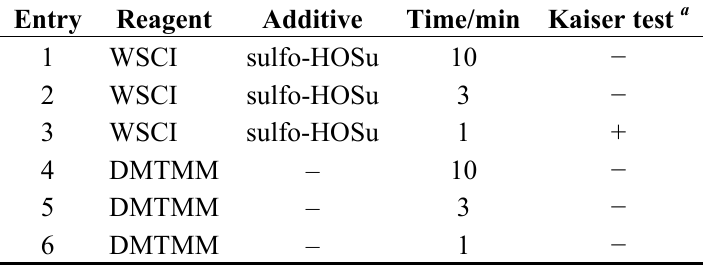
Table 1. Study of MW assisted solid-phase coupling reaction in water [24]. Reactions were carried out between Boc-Phe-OH nanoparticles and H-Gly-Rink amide-PEG grafted resin. Entry Reagent Additive Time/min Kaiser test a 1 WSCI sulfo-HOSu 10 − 2 WSCI sulfo-HOSu 3 − 3 WSCI sulfo-HOSu 1 + 4 DMTMM – 10 − 5 DMTMM – 3 − 6 DMTMM – 1 − a Kaiser test